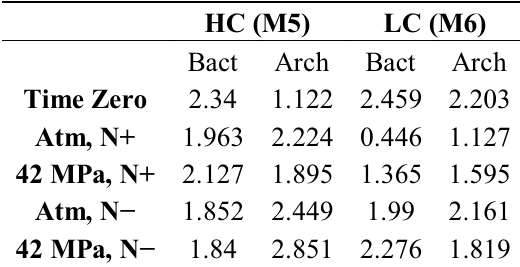
Table 3. (cid:37)(cid:68)(cid:70)(cid:87)(cid:72)(cid:85)(cid:76)(cid:68)(cid:3) (cid:68)(cid:81)(cid:71)(cid:3) (cid:36)(cid:85)(cid:70)(cid:75)(cid:68)(cid:72)(cid:68)(cid:29)(cid:3) (cid:54)(cid:75)(cid:68)(cid:81)(cid:81)(cid:82)(cid:81)(cid:182)(cid:86)(cid:3) (cid:71)(cid:76)(cid:89)(cid:72)(cid:85)(cid:86)(cid:76)(cid:87)(cid:92)(cid:3) (cid:76)(cid:81)(cid:71)(cid:72)(cid:91)(cid:3) (cid:11)(cid:43)(cid:12)(cid:17)(cid:3) (cid:54)(cid:72)(cid:83)(cid:68)(cid:85)(cid:68)(cid:87)(cid:72)(cid:3) (cid:89)(cid:68)(cid:79)(cid:88)(cid:72)(cid:86)(cid:3) (cid:68)(cid:85)(cid:72)(cid:3) presented for bacterial and archaeal populations and were calculated using DGGE band peak heights. N+ denotes incubation with added nutrients; N (cid:237) denotes incubation without nutrient